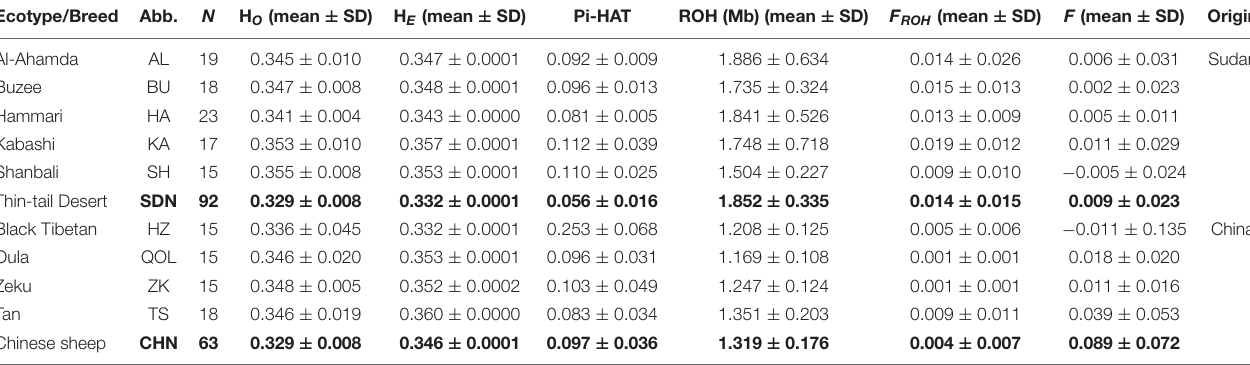
TABLE 1 | Genetic diversity estimates in the five ecotypes of Sudanese thin-tailed Desert Sheep and the four breeds of sheep from China analyzed in this study. Ecotype/Breed Abb. N H O (mean ± SD) H E (mean ±